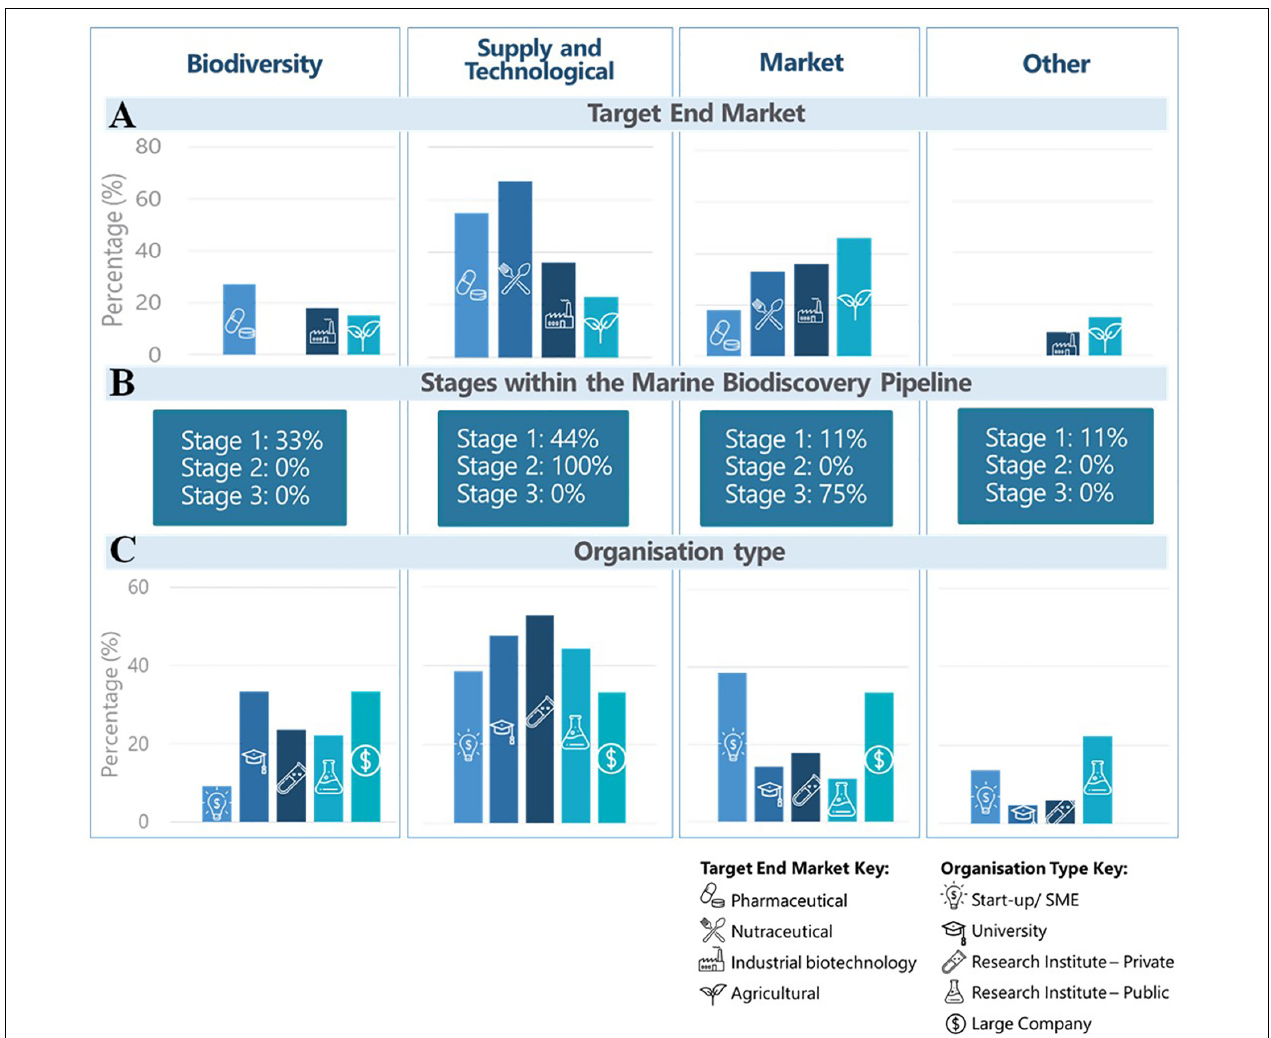
FIGURE 6 | Trends in challenges linked to (A) target end markets, (B) stages within the marine biodiscovery value chain, and (C) organization